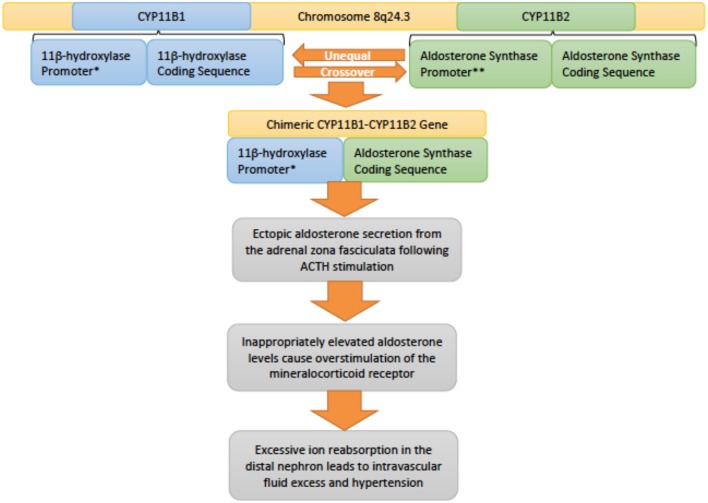
An overview of the genetic pathophysiology of familial hyperaldosteronism type I. * Promoter responsive to adrenocotropic hormone (ACTH). **Promoter responsive to angiotensin II.